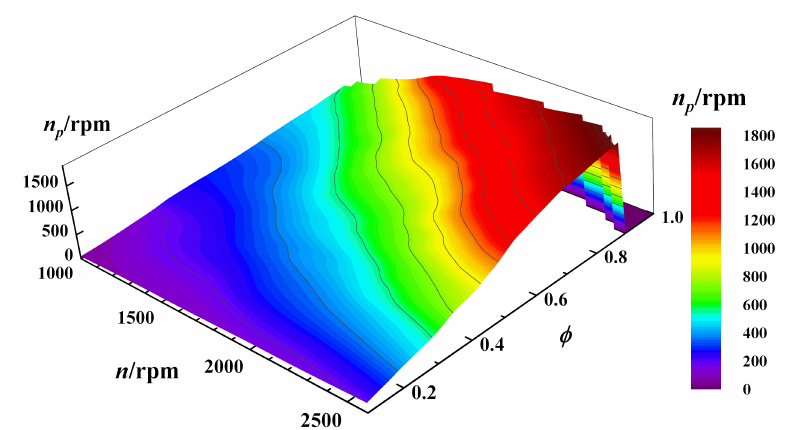
Figure 13. Speed map of water pump for T atm = 35 ◦